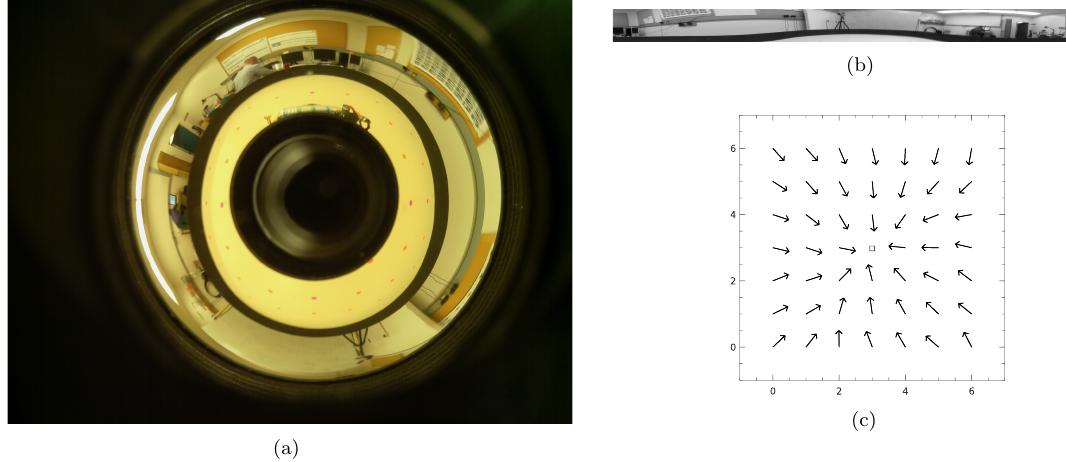
Figure 2: (a) Raw and (b) unfolded images from the Bubblescope/RPi camera for position (3,3). (c) Unit vectors indicating the computed direction of goal position (3, 3) using visual